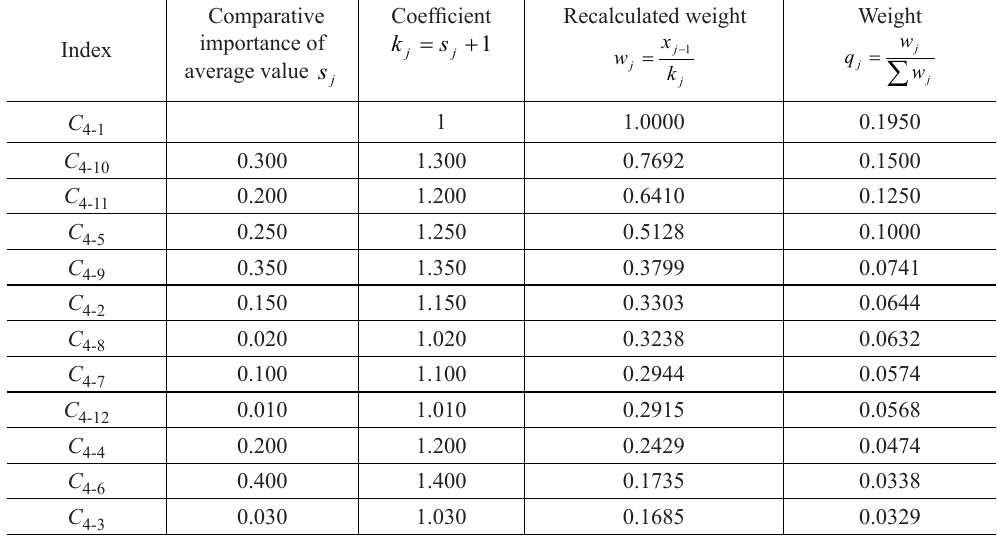
Table 8. Priorities and final weights of sub-indexes reflecting economic